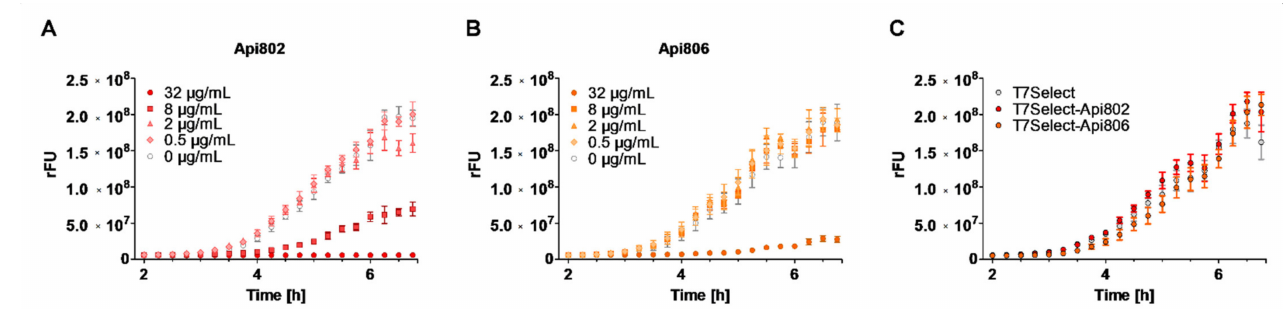
Figure 6. Expression of GFP by E. coli R2.3 monitored by its inherent fluorescence in the presence of different Api802 ( A ) and Api806 ( B ) concentrations and engineered apidaecin phages ( C ). ( A , B ) E. coli Rosetta was pre-incubated with T7Select (MOI 0.01) in LB medium for 30 min, before different concentrations of Api802 ( A ) and Api806 ( B ) as well as an E. coli R2.3 culture (10-fold lower cell count) were added. GFP expression was induced with IPTG; ( C ) E. coli Rosetta was pre-incubated with T7Select, T7Select-Api802, or T7Select-Api806 (MOI 0.01) in LB medium. E. coli Rosetta R2.3 was added in 10-fold lower cell numbers. GFP expression was initiated with IPTG. Experiments were completed twice in ten replicates. Error bars show the standard deviation of all ten replicates of one representative